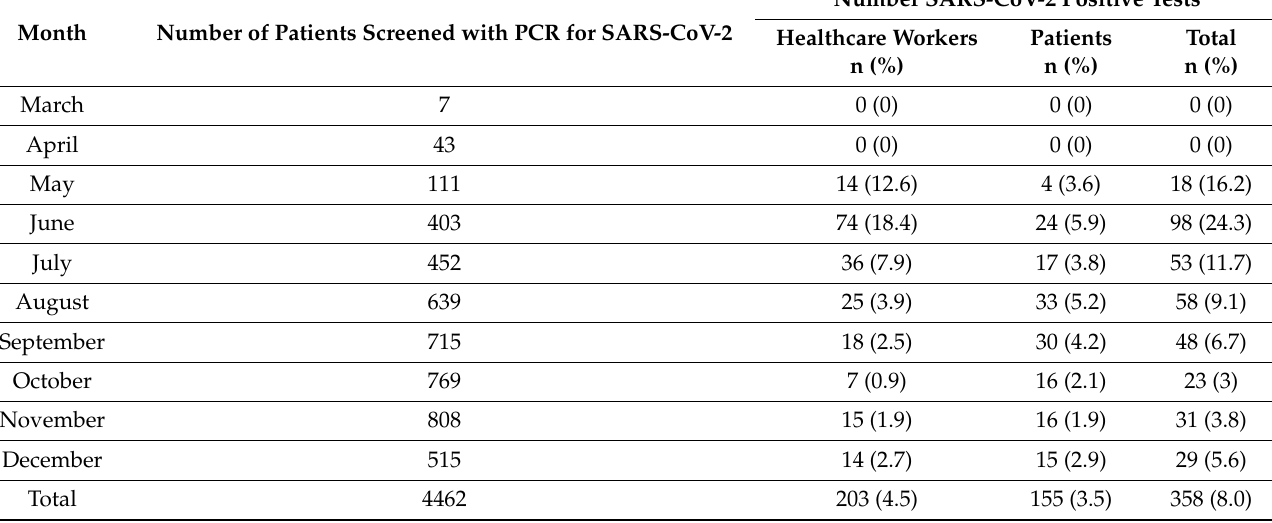
Table 1. Rate of monthly COVID-19 cases at Prince Sultan Cardiac Center from 2 March to 31 December 2020. Month Number of Patients Screened with PCR for SARS-CoV-2